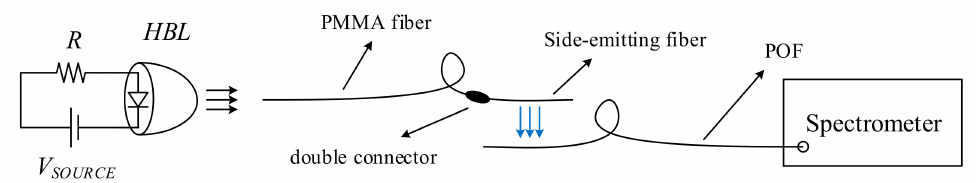
Figure 10. Test setup for the assessment of the wavelength dependent coupling loss of the extended sensing area intra-oral sensor.